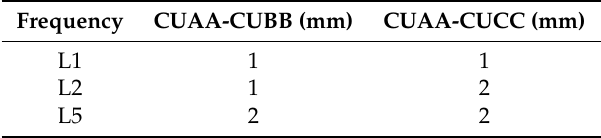
Table 1. Zenith-referenced phase standard deviations for baselines CUAA-CUBB and CUAA-CUCC.